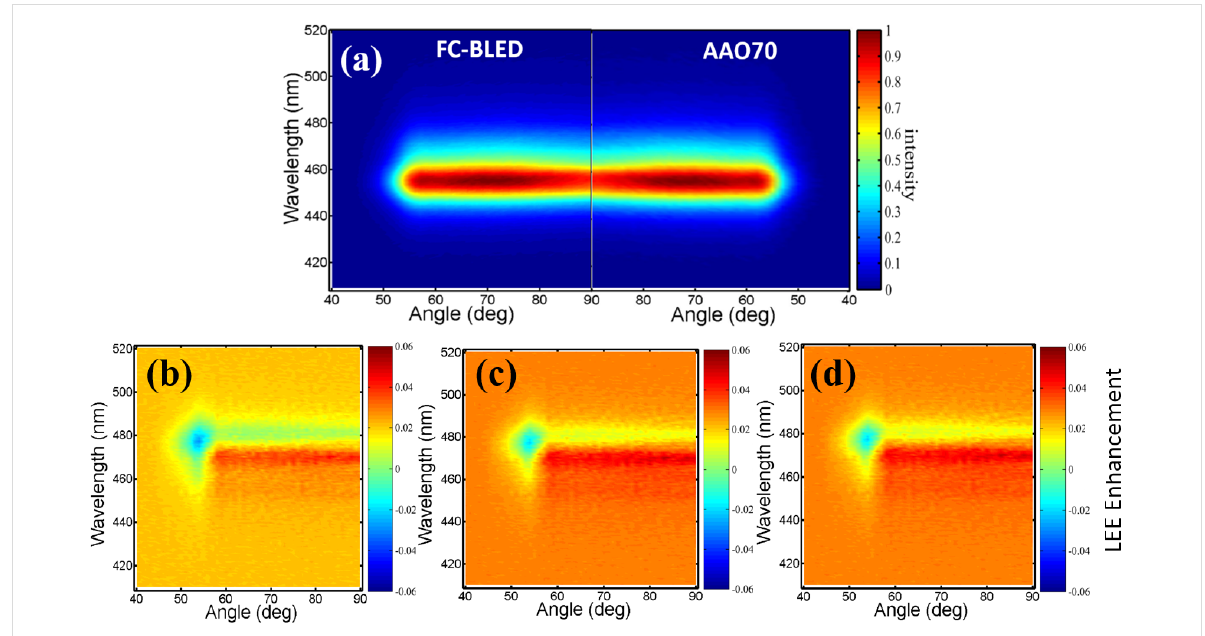
Figure 7: (a) Angle-resolved electroluminescence (AREL) spectra of samples FC-BLED and AAO70. Angular resolution of LEE enhancement of (b) AAO60, (c) AAO70, and (d) AAO80.